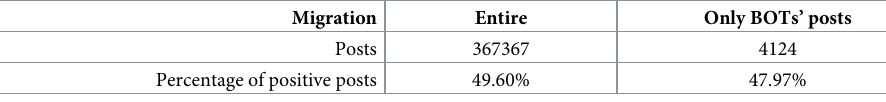
Table 1. “Migration” sample: Descriptives of the sample obtained with T = 0.35.